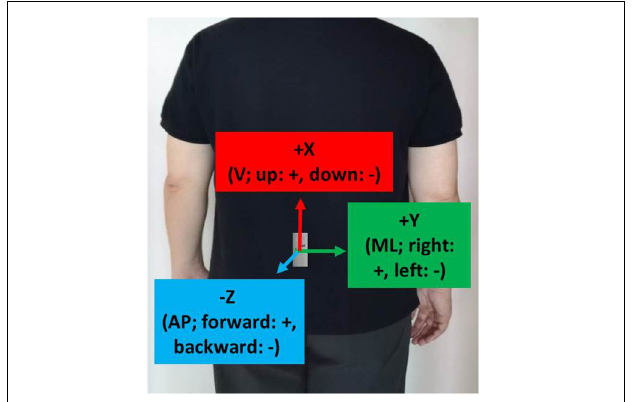
FIGURE 1 | Sensor locations and corresponding axes/directions.